Question: What direction does the quantity move in — increasing or decreasing?
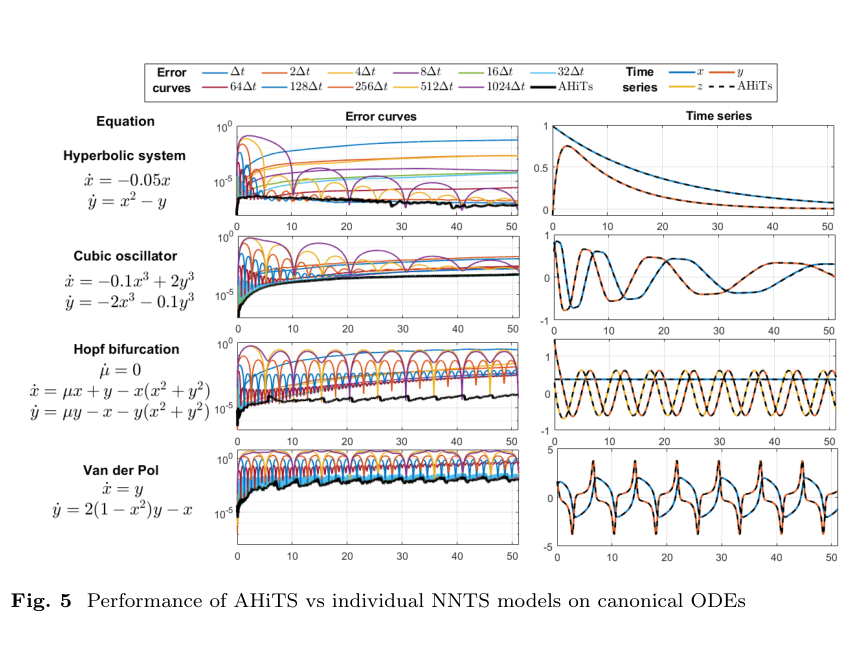
Answer: increasing